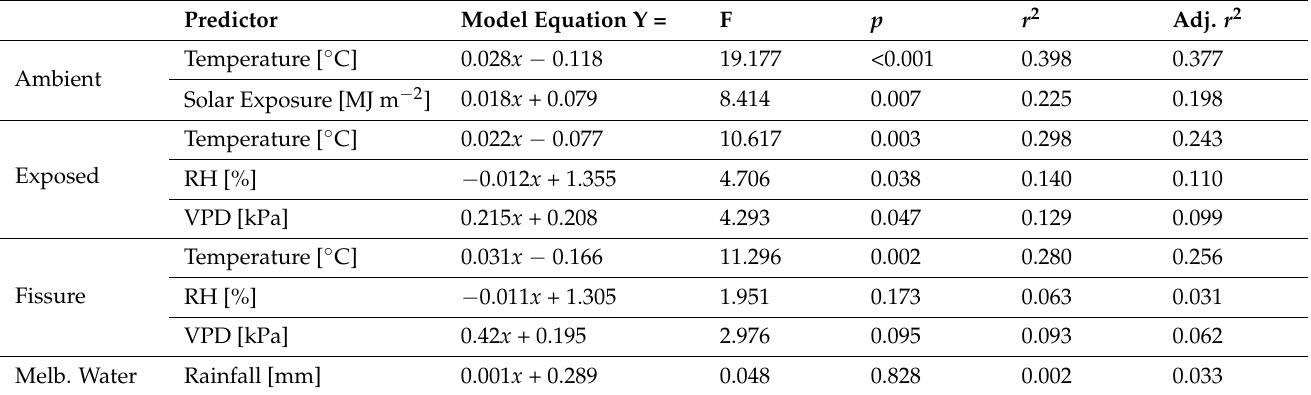
Table A10. Summary of climate regression models predicting the percentage of honeydew producing Marchalina hellenica . Climate records used in models represent the fortnightly mean value of daily maximum, except rainfall; recorded cumulatively in millimetres. N = 30 for each regression analyses.